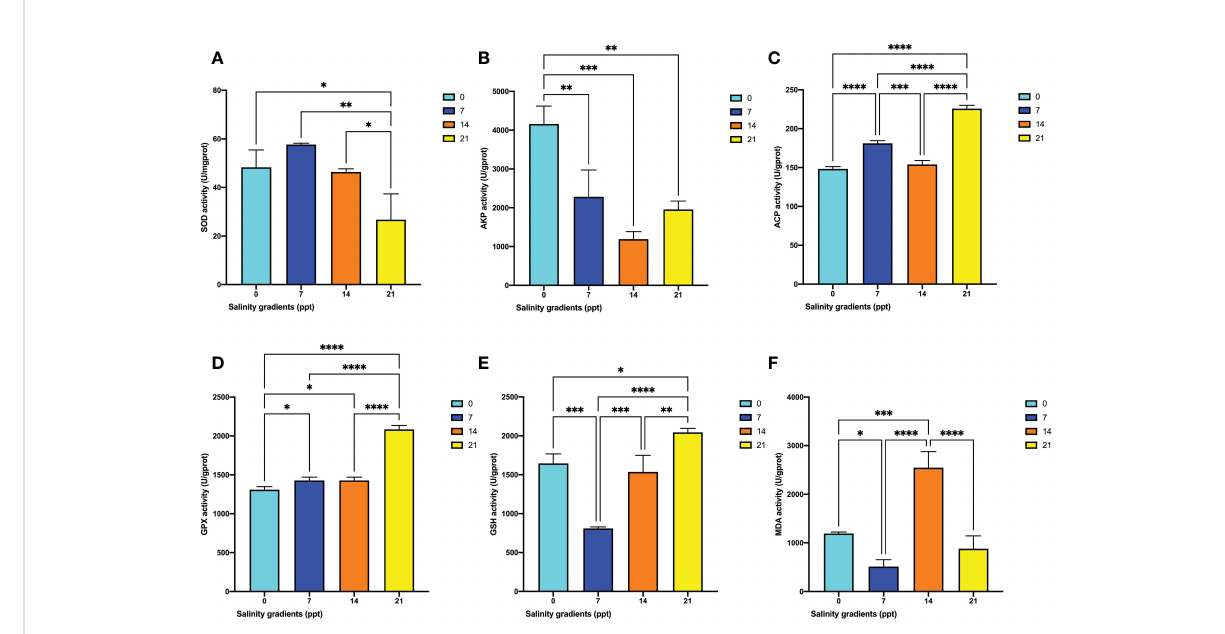
FIGURE 5 The changes of six antioxidant enzyme activities in the hepatopancreas of M. nipponense exposed to four salinity gradients. (A) SOD; (B) AKP; (C) ACP; (D) GPX; (E) GSH; (F) MDA. * indicates the extent of signi fi cant difference (*: p < 0.05, **: p < 0.01, ***: p < 0.001, ****: p < 0.0001).